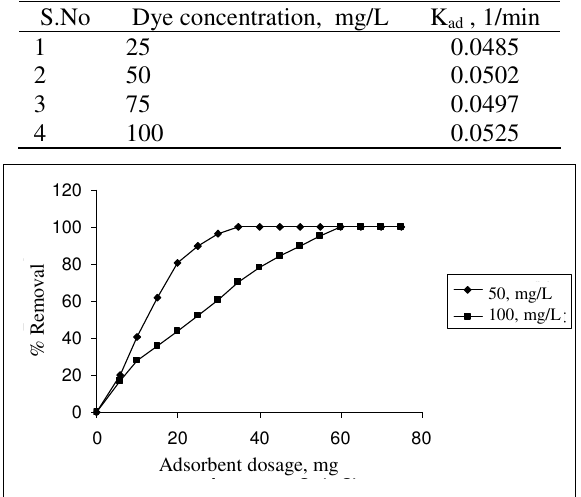
Table 2. Lagergren rate constant for crystal violet adsorption.